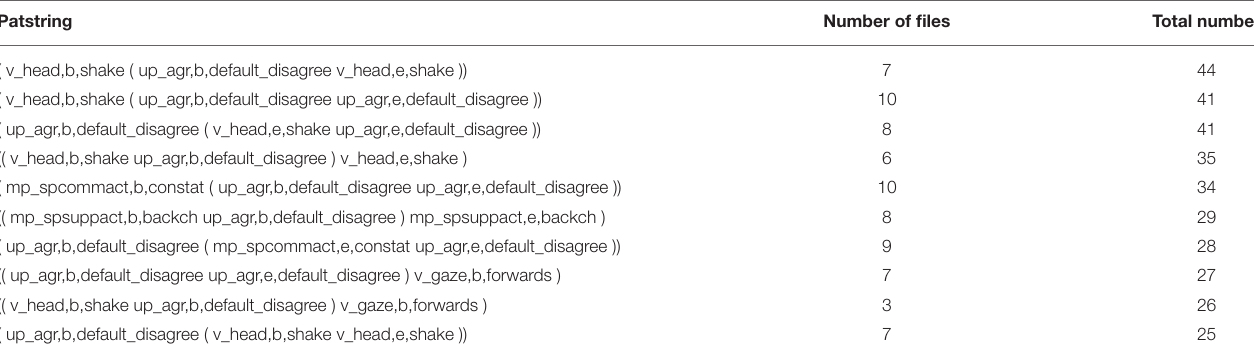
TABLE 11 | The most frequent patterns of agreement consisting of 3 events.